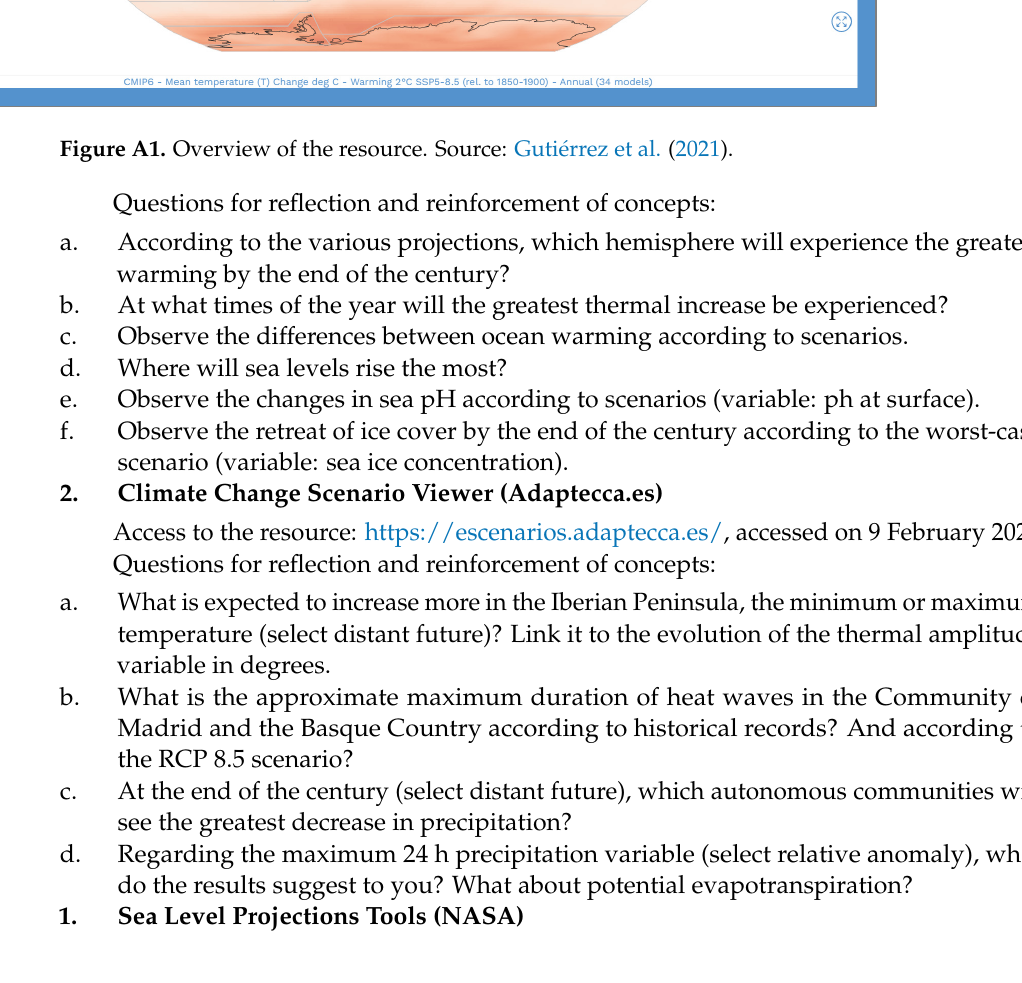
Figure A2. Overview of the resource. Source: Adaptecca.es (2021). Questions for reflection and reinforcement of concepts: